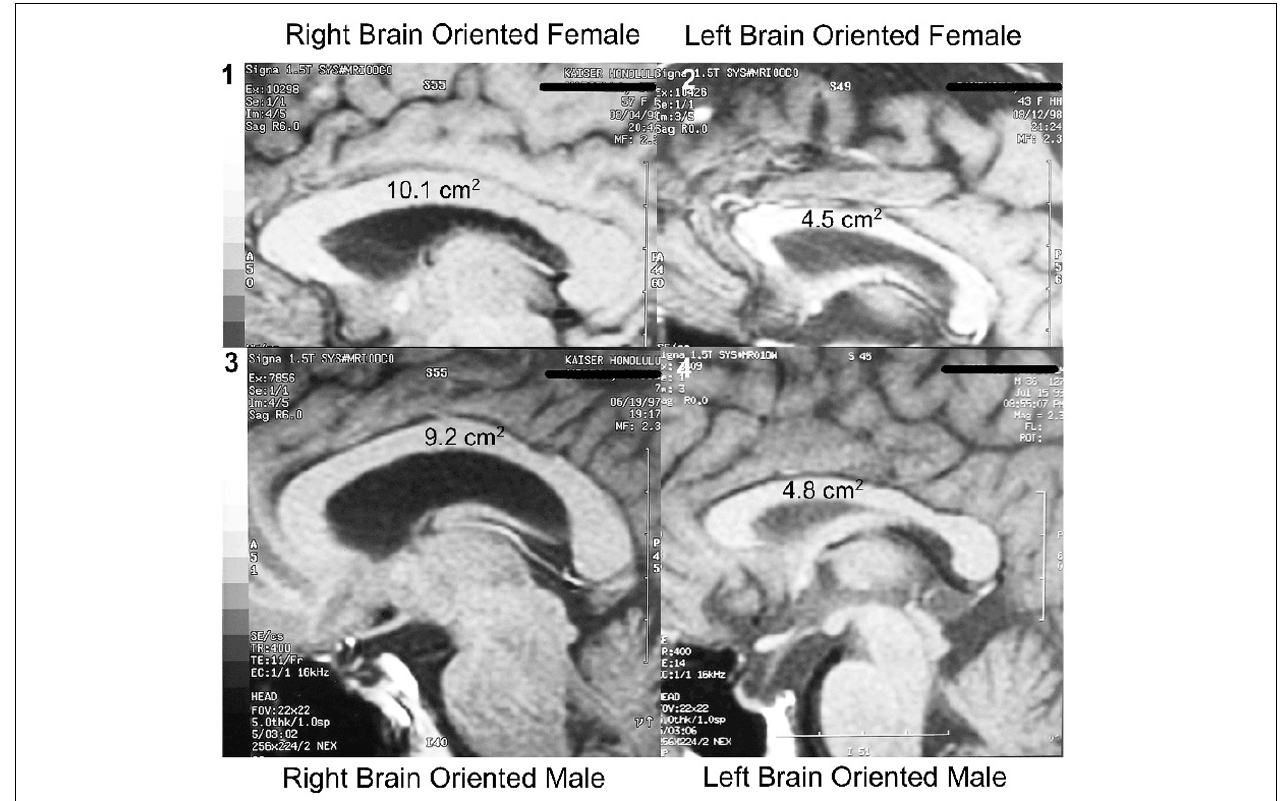
FIGURE 2 | Hemisityvs.sex:sizerangeofcorpuscallosalareas. LargestCCAsofthesubjectgroup( n = 113): (1) Rightbrain-orientedfemale,10.1cm 2 . (3) Right brain-oriented male, CCA 9.2cm 2 . Smallest CCAs: (2) Left brain-oriented female, 4.5cm 2 . (4) Left brain-oriented-male, 4.8cm 2 . From Morton and Rafto (2006).